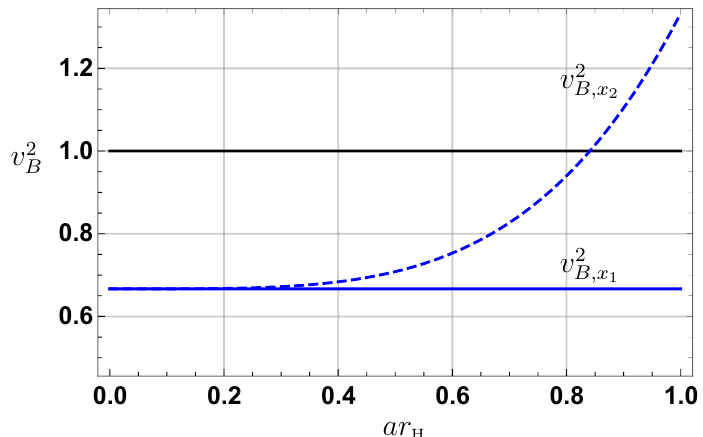
versus the dimensionless parameter ar Figure 1 . Butterfly velocity squared v 2 B blue line represents the butterfly velocity along the x -direction, which does not depend on ar 1 takes the conformal value v 2 = 2 / 3 , while the dashed blue curve represents the butterfly velocity B along the x - and x -directions. The horizontal black line corresponds to the speed of 2 3